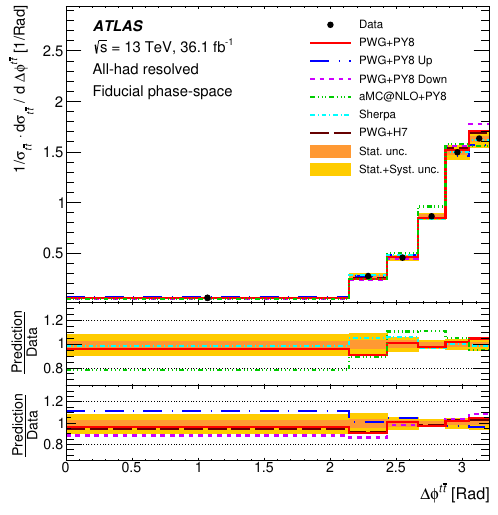
Figure 9 . Particle-level normalised single-differential cross-sections as a function of the azimuthal separation ∆ φ t ¯ t between the two top-quark candidates. In the top panel, the unfolded data are shown as black points, while lines indicate the predictions from several MC programs. Uncertainties are shown by the shaded bands. Data points are placed at the centre of each bin. The lower two panels show the ratio of the MC predictions to the unfolded data.